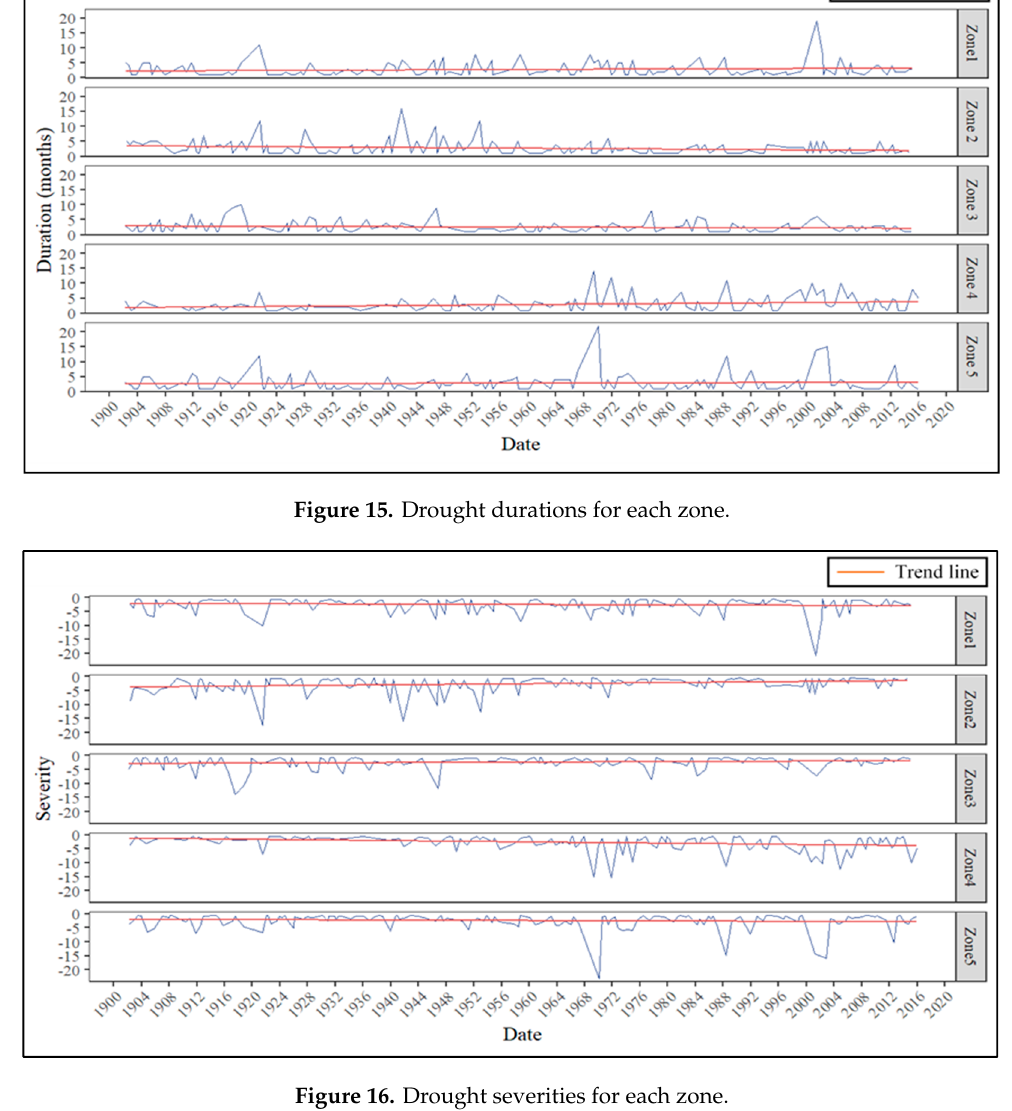
Figure 16. Drought severities for each zone.